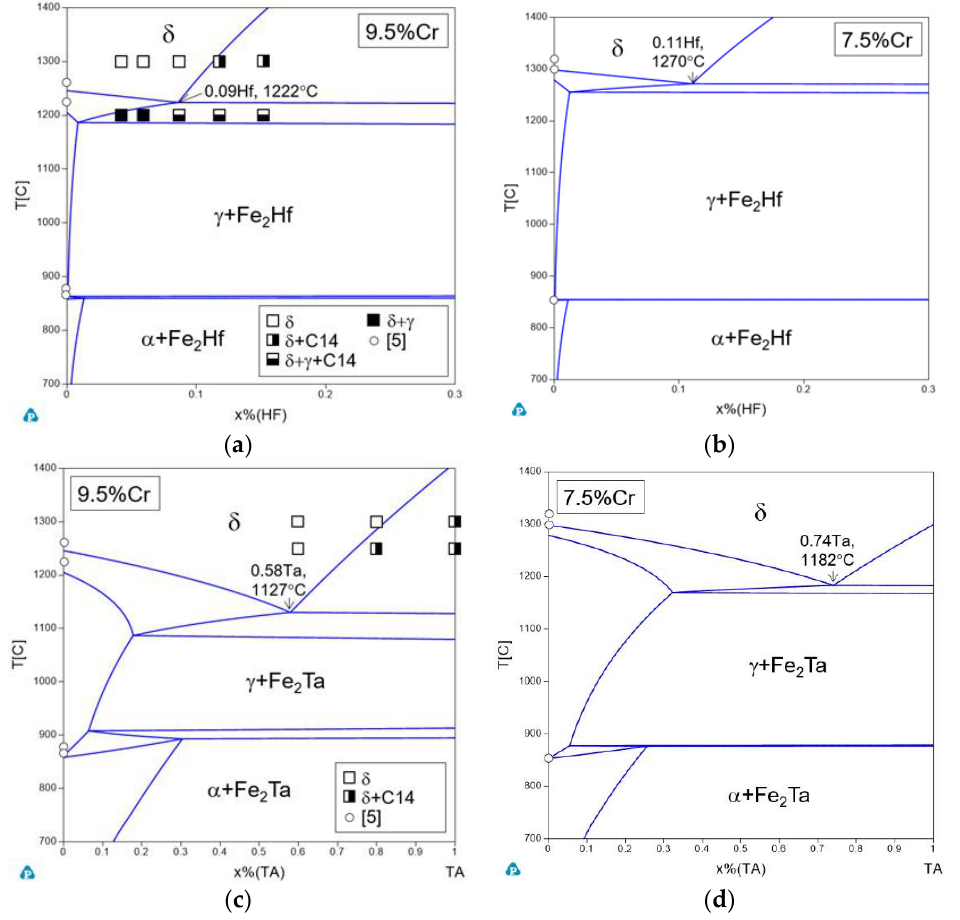
Figure 5. Calculated vertical sections of phase diagram in the Fe-Cr-M (M: Hf, Ta) ternary systems: ( a ) Fe-9.5Cr-Hf, ( b ) Fe-7.5Cr-Hf, ( c ) Fe-9.5Cr-Ta, ( d ) Fe-7.5Cr-Ta. Eutectoid coordinates are designated in each section. Experimentally determined phase fields are also shown.